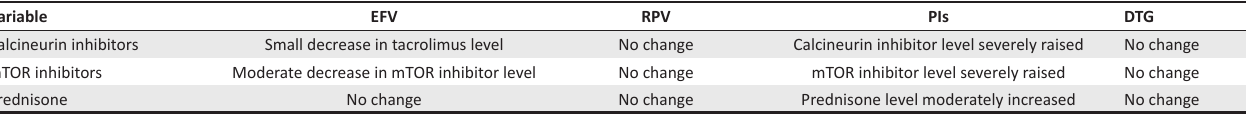
TABLE 1: Key drug–drug interactions between commonly used immunosuppressant and antiretroviral drugs. Variable Calcineurin